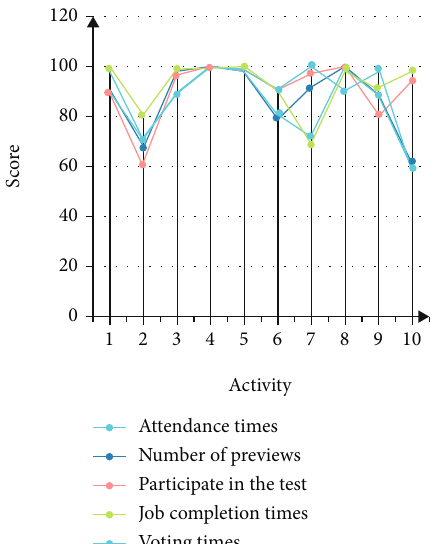
Figure 3: Visualization results of students ’ learning attitudes and necessary learning activities